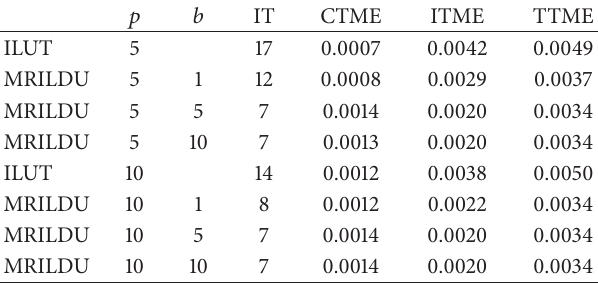
Table 14: Iteration results for